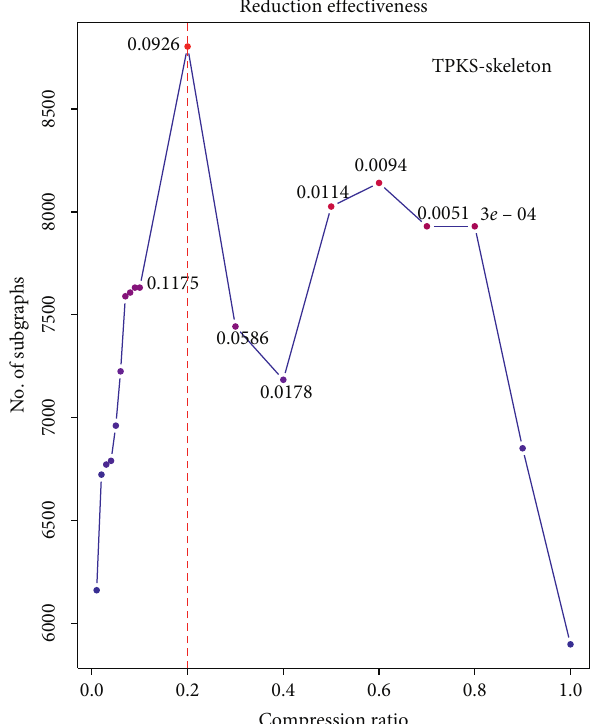
Figure 1: The range of reduction effectiveness denotes the number of generated isolated subnetworks at different compression ratios. The values of the coordinate points indicate the coverage ratio of an extracted